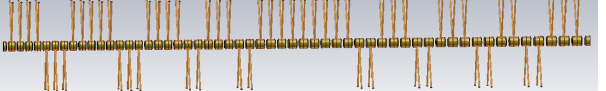
FIG. 18. Stem configuration M determined through tuning the local flatness of the TM 011 -mode.